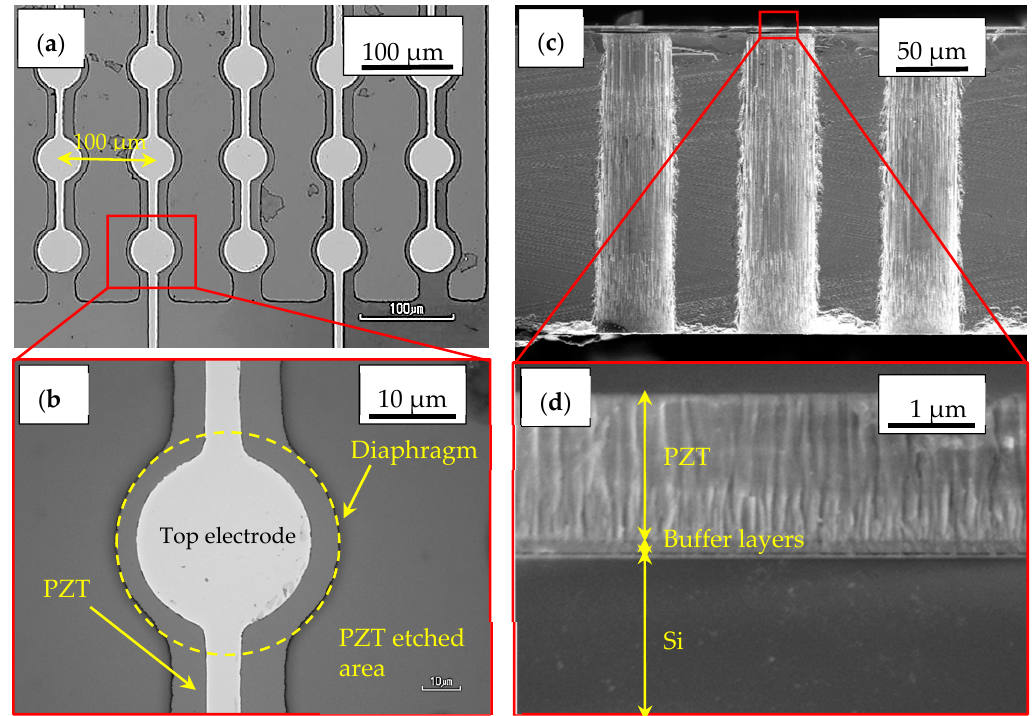
Figure 7. Optical images of ( a ) pMUT linear array and ( b ) single element, respectively; ( c , d ) Cross-sectional SEM images of the array and fibered-epitaxial thin film on the membrane. The curvatures of the membrane for both devices were observed using a white light interference meter (NewView™ 9000 3D Optical Surface Profiler, ZYGO, Middlefield, CT, USA). Figure 8a,d are